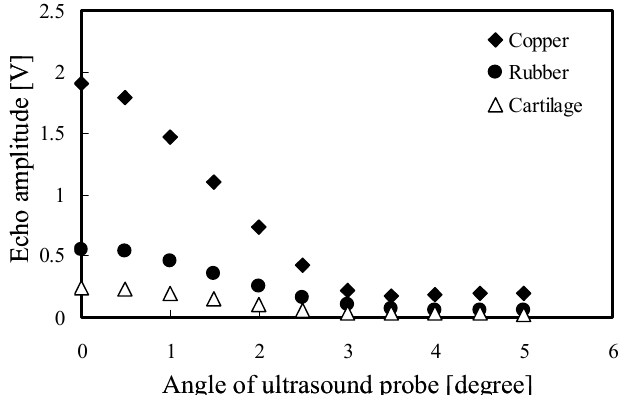
Figure 6: Relationship between echo amplitude and probe angle. Copper, rubber and articular cartilage were used as reflection surfaces. Mean values (SD) are shown for 0.0-5.0